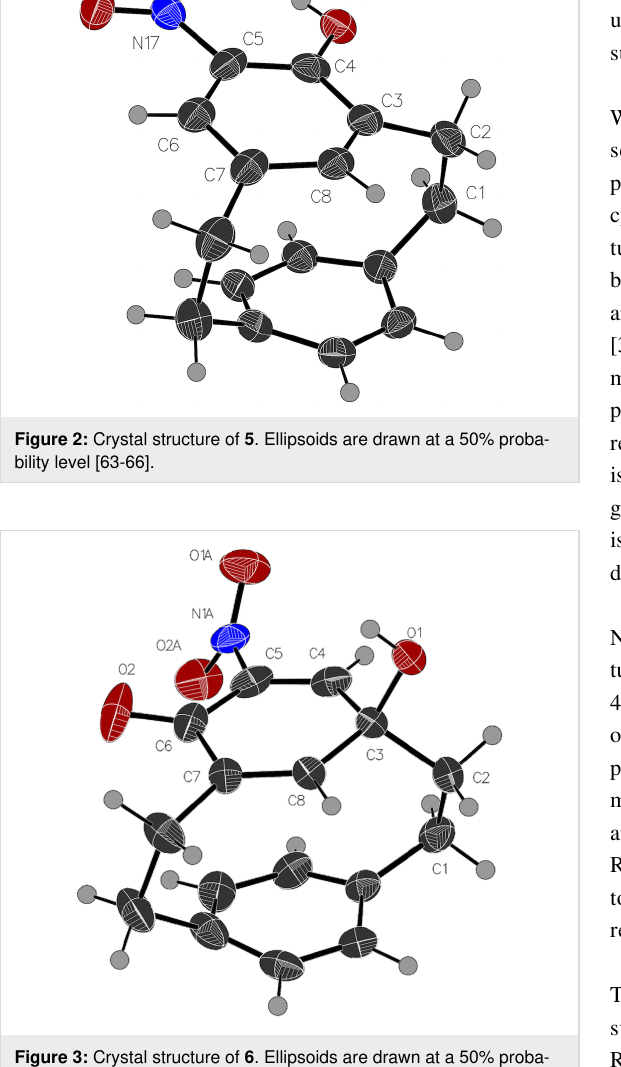
The structure of the disubstituted [2.2]metaparacyclophane ( 5 ) is analogous to that of the unsubstituted [2.2]metaparacyclo- phane ( 3 ). The angle between the two aromatic rings as defined by carbon atoms 3–7 on the meta -ring and 12, 13, 15, 16 on the para -ring is 13.1° for [2.2]metaparacyclophane ( 3 ) [32], and 13.9° for the disubstituted derivative 5 . The nitro group is held in the plane of the meta -ring by hydrogen bonding with the hydroxy group at